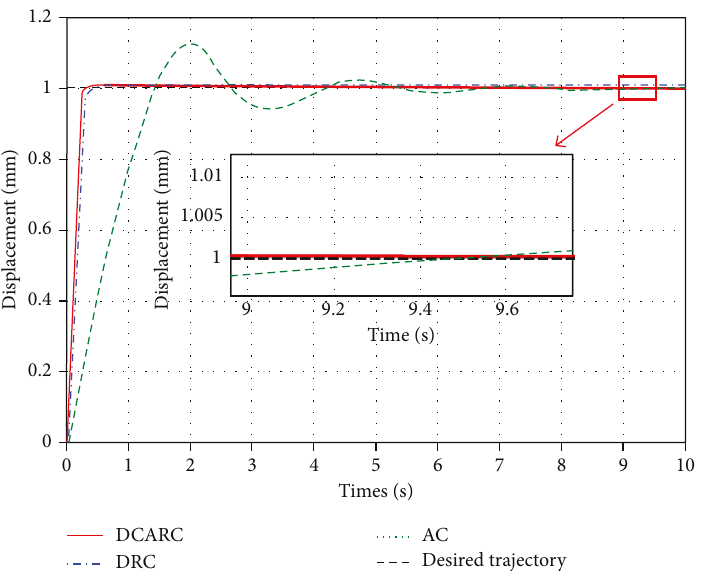
Figure 5: Trajectory